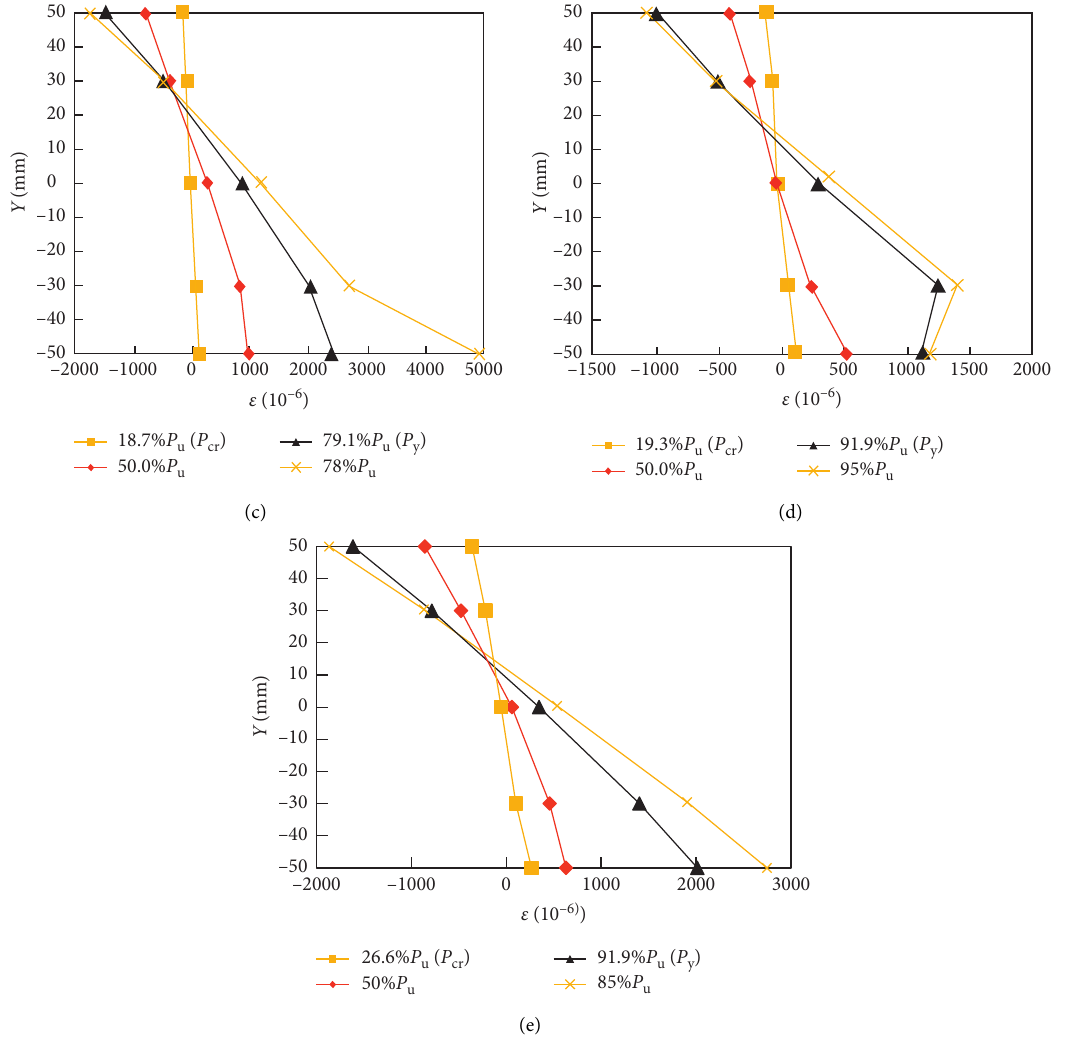
Figure 17: Distribution of longitudinal strain on midspan section: (a) HSC1-1; (b) HSC1-2; (c) HSC1-3; (d) HSC1-4; (e)